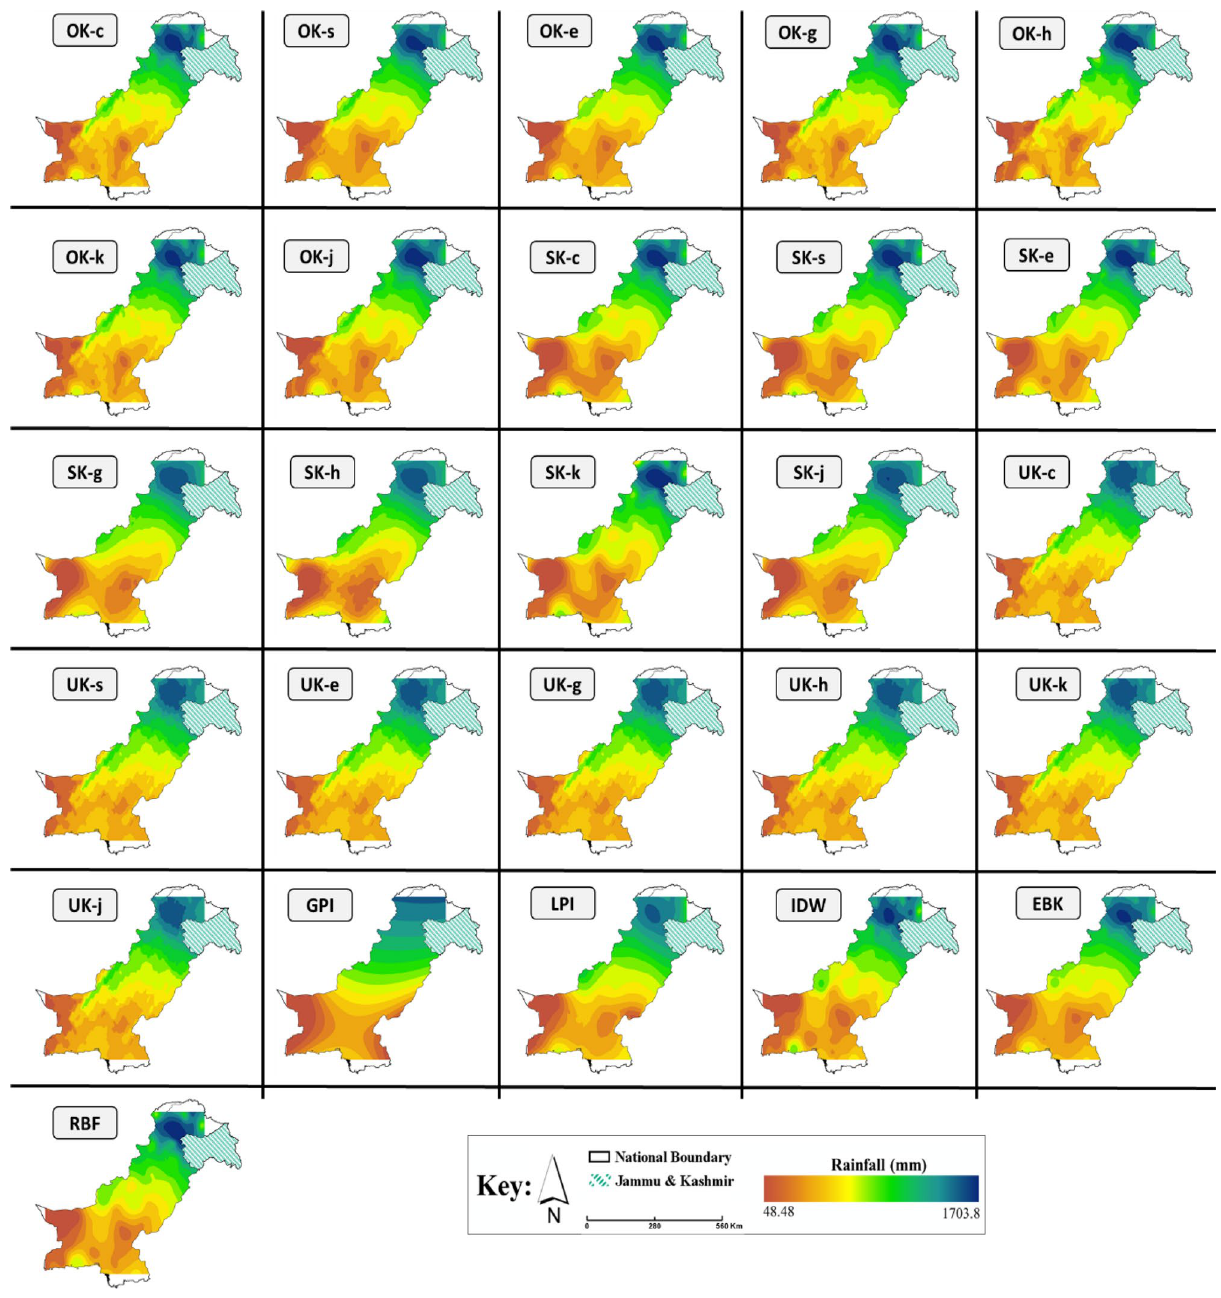
by a co-author M.S., available at www. esri.